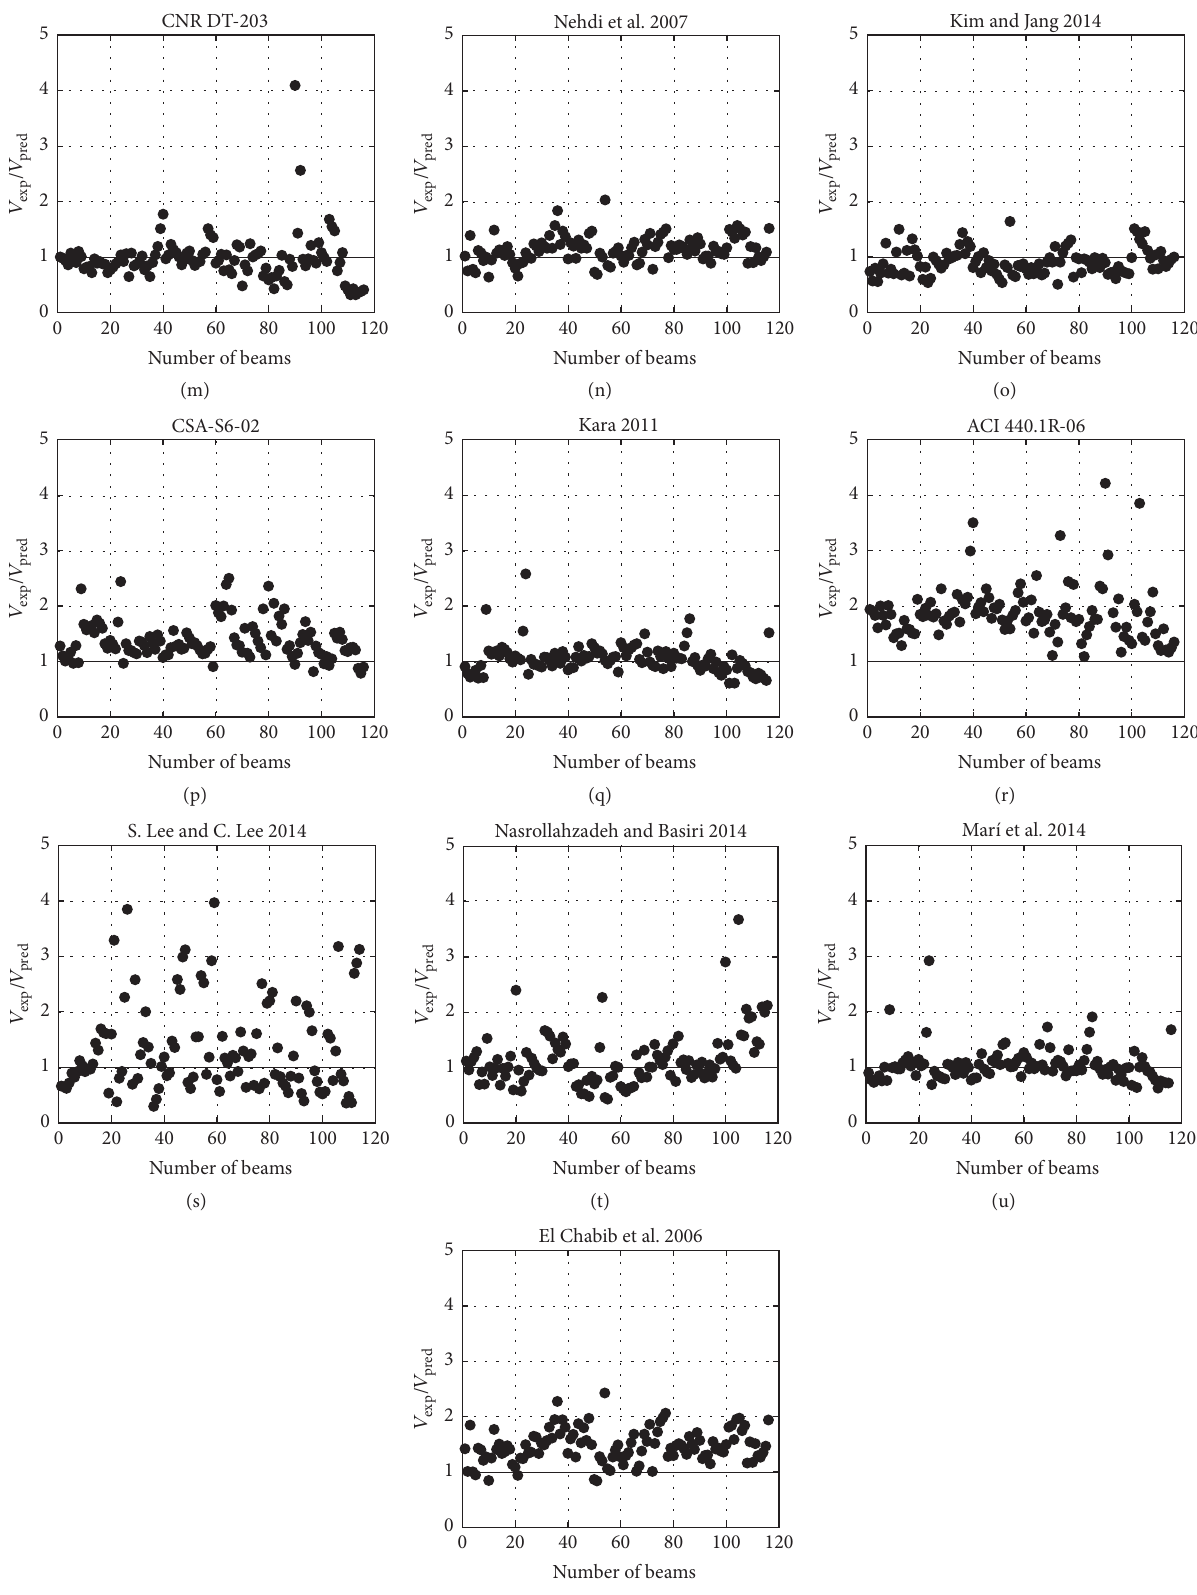
Figure 6: 𝑉 exp /𝑉 pred versus number of